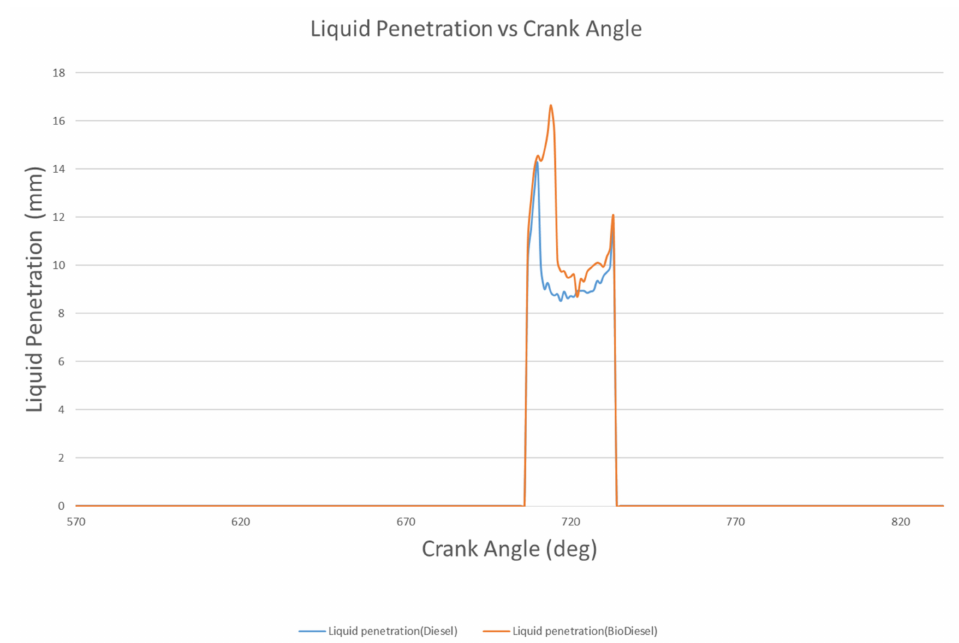
Figure 4. Liquid penetration length vs. crank angle.